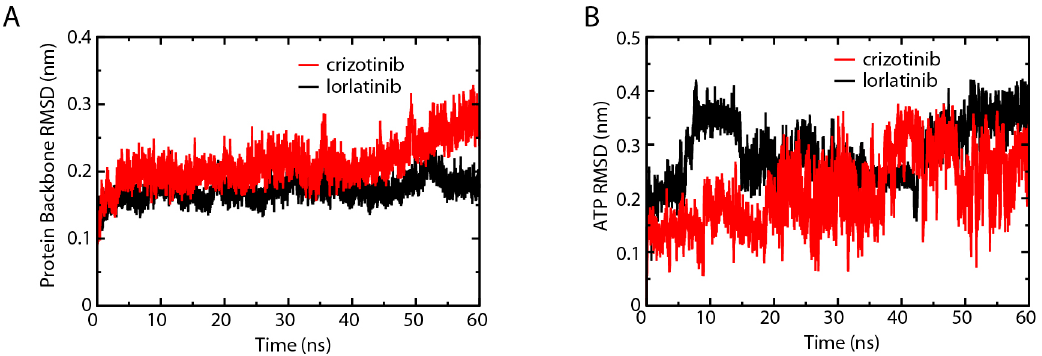
Figure 8. Root-mean-square deviation (RMSD) comparison of ALK–ATP complexes. Root-mean-square deviations of the protein backbones ( A ); and ATP ( B ) in ALK–crizotinib and ALK–lorlatinib complexes were calculated and compared.